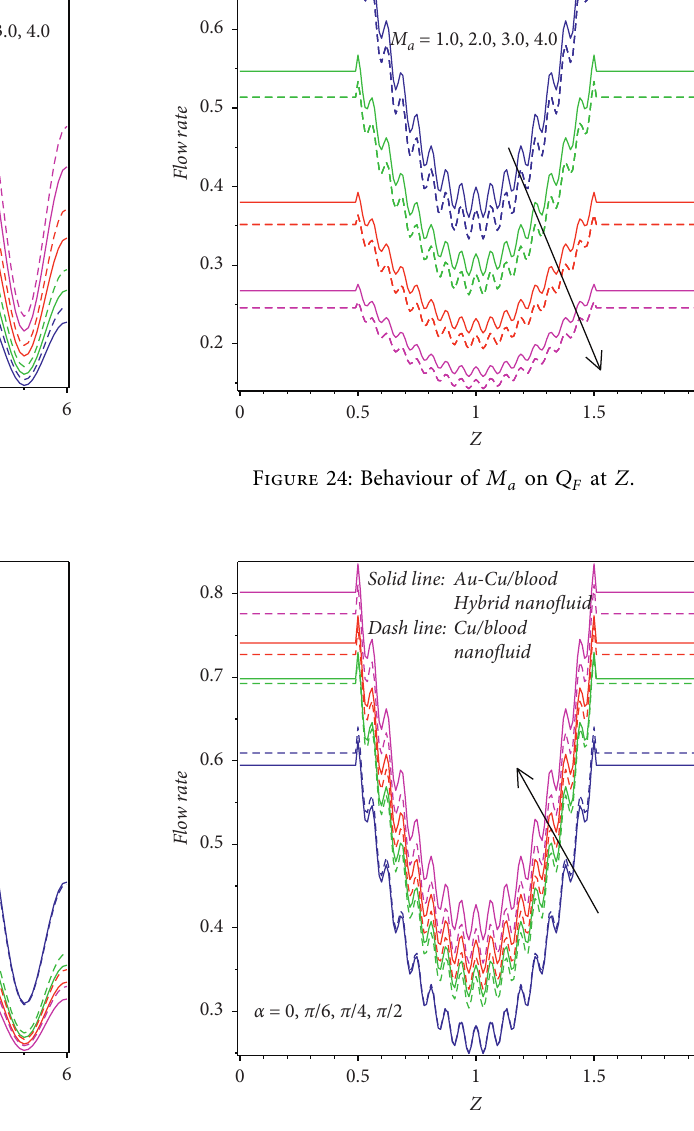
Figure 25: Behaviour of α on Q